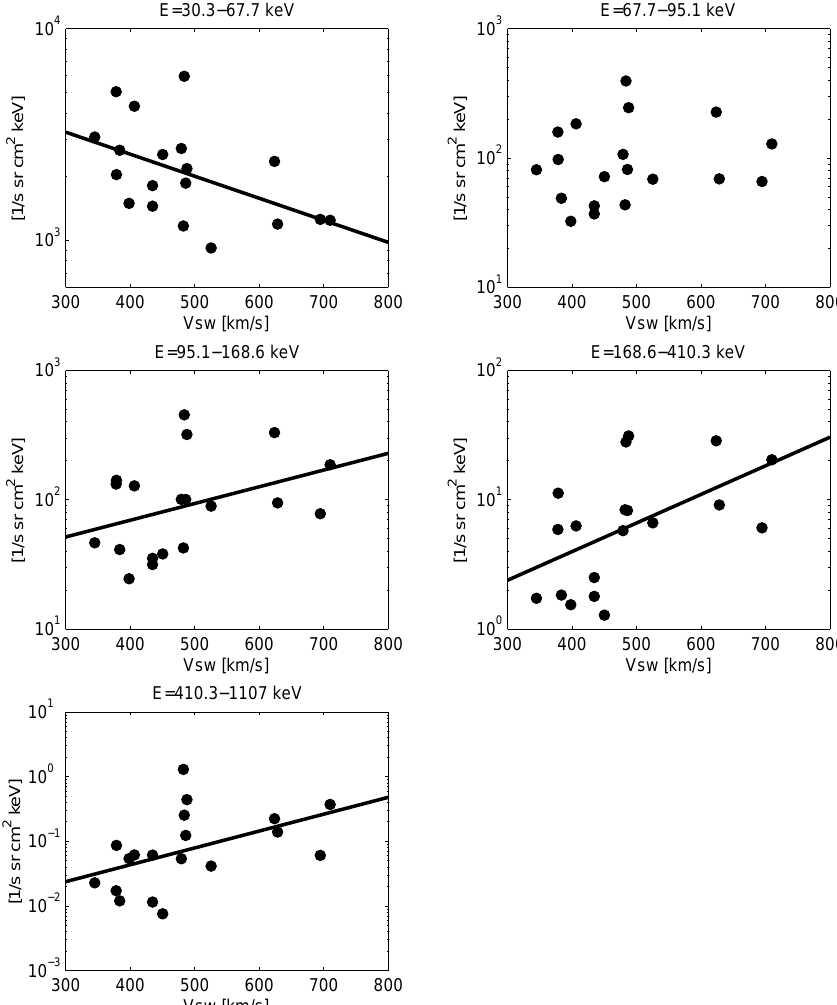
Fig. 8. Differential proton fluxes (five lowest energy channels) in the exterior cusp as a function of solar wind speed.